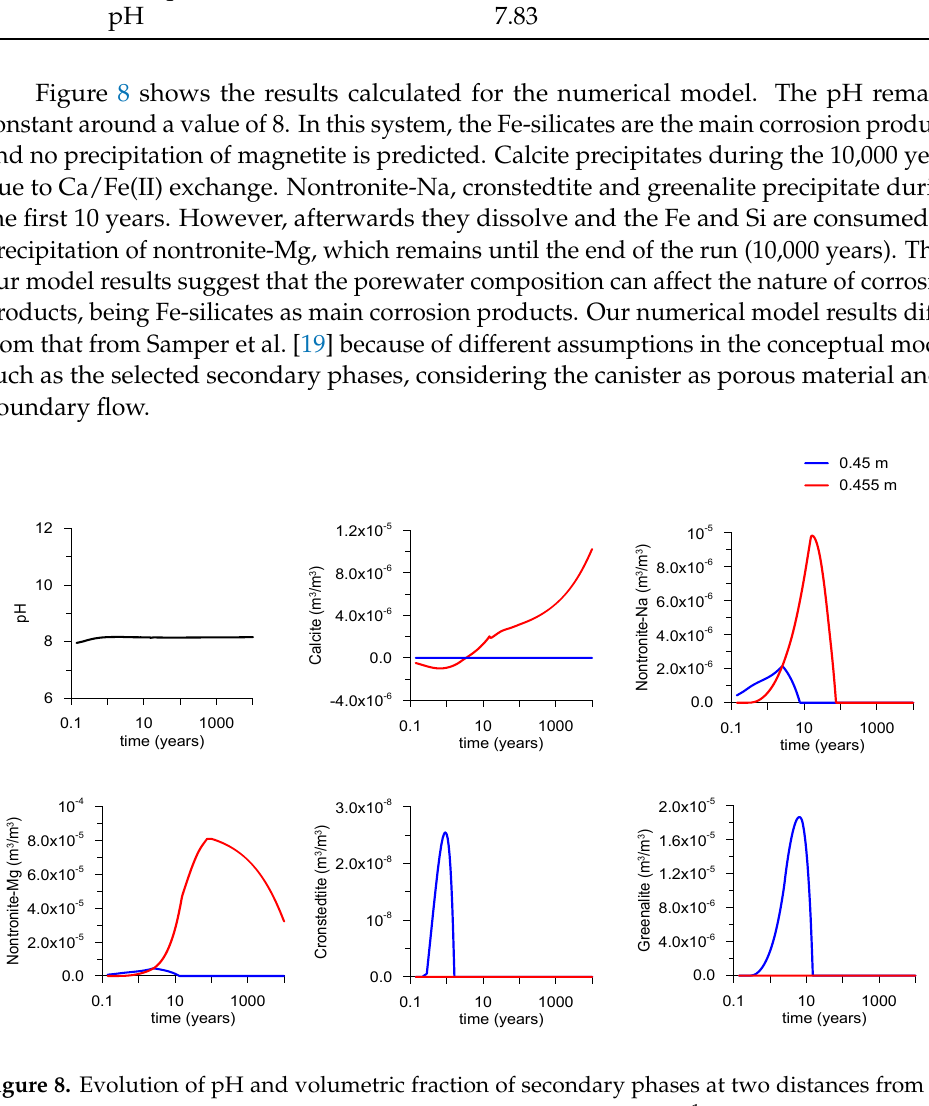
Figure 8. Evolution of pH and volumetric fraction of secondary phases at two distances from the steel/bentonite interface considering a granitic porewater (r c = 2 µ m y − 1